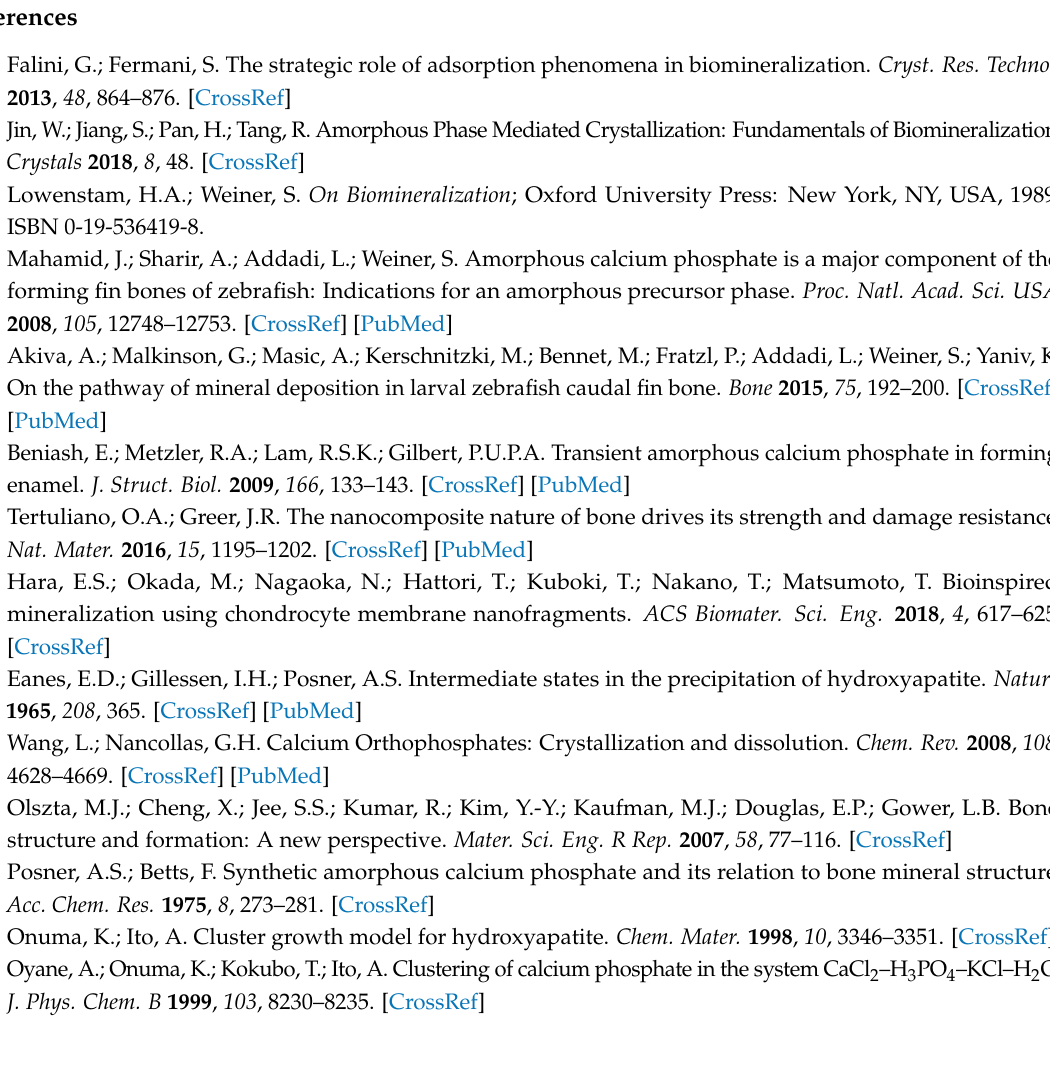
Figure S1: Particle height analysis of atomic force microscopy (AFM) 2D height for the particles formed in precipitation systems without stirring; Figure S2: AFM 3D topographic view of aggregated nanoparticles obtained in precipitation System A with stirring; Figure S3: Particle height analysis of AFM 2D height for the particles formed in precipitation systems with mechanical stirring; Figure S4: Transmission Electron Microscopy (TEM) micrographs and the corresponding particles length distributions; Figure S5: Distribution of particles’ sizes obtained in time-averaged experiment and representative distributions obtained in time-resolved experiment at corresponding reaction times; Figure S6: Changes of vol. % of particles formed in systems A and B, without stirring measured by dynamic light scattering (DLS) time resolved experiment at the same time scale. Table S1: Particle height analysis of AFM 2D height for the particles formed in precipitation systems without stirring; Table S2: Particle height analysis of AFM 2D height for the particles formed in precipitation systems with mechanical